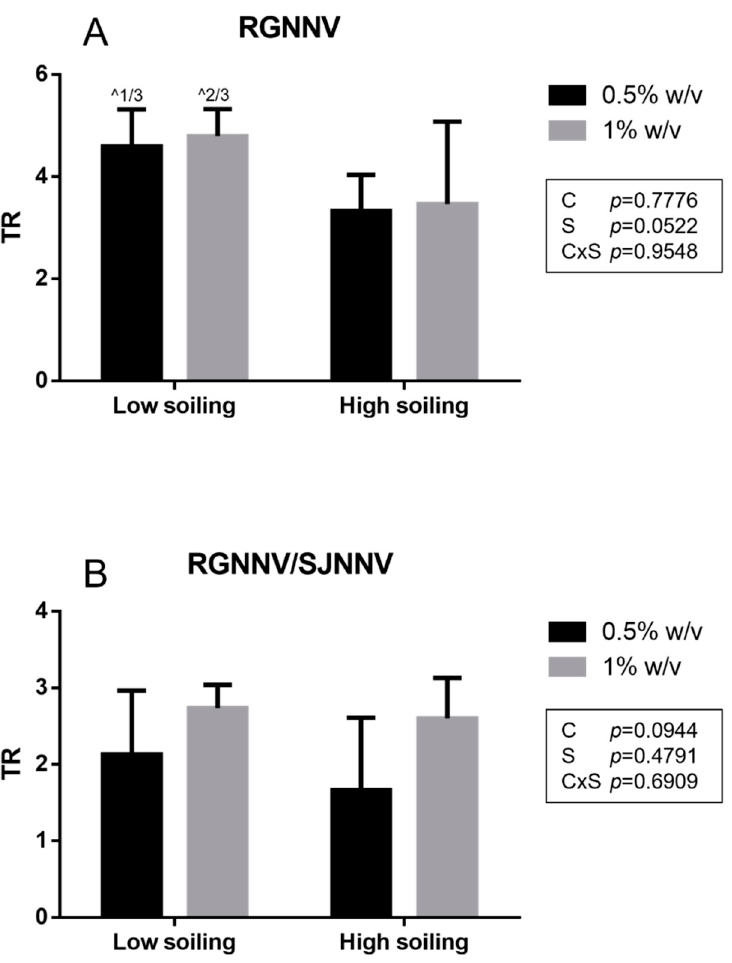
Figure 2. Net test results obtained for the RGNNV strain ( A ) and the reassortant RGNNV/SJNNV strain ( B ). TR: titer reduction; C: disinfectant concentration; S: soiling level. The same superscript letters indicate significant differences among titer reduction values ( p ≤ 0.05). ^ indicates the number of test repeats where no CPE was detected.